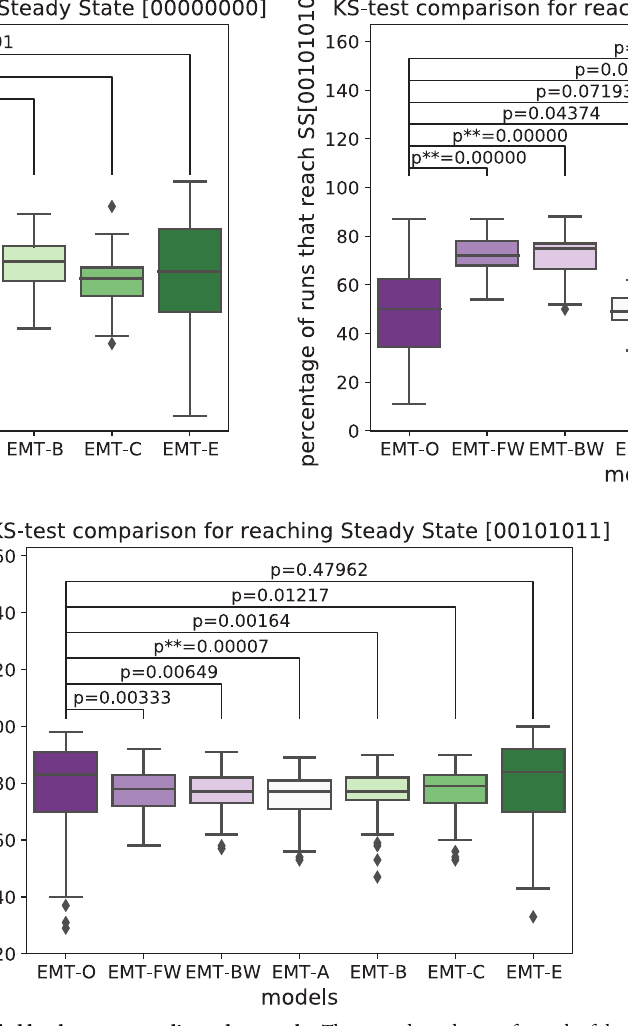
Fig 5. Frequency distribution of the states divided by the corresponding subnetworks. The second steady state for each of those subnetworks is omitted, since it is the complement of the depicted plots here. The noted p-value is taken from a Kolmogorov-Smirnov test between the distribution of frequencies between the original model EMT-O and EMT-FW, EMT-BW, EMT-A, EMT-B, EMT-C, and EMT-E, respectively. The top left figure depicts the distribution of all states that can reach the attractor (00000000). The figure in the top right depicts the distribution of all states that can reach the attractor (00101010). The figure on the bottom depicts the distribution of all states that can reach the attractor